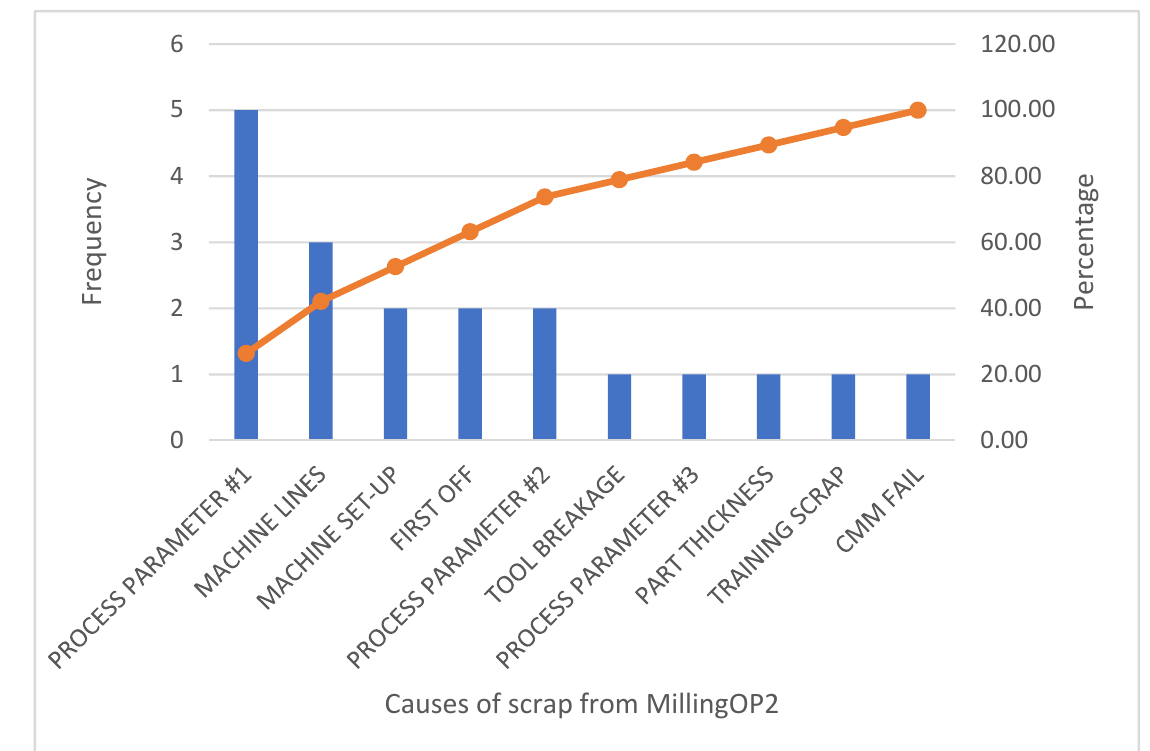
Figure 9. Pareto chart of causes of scrap in CNC–CMM.